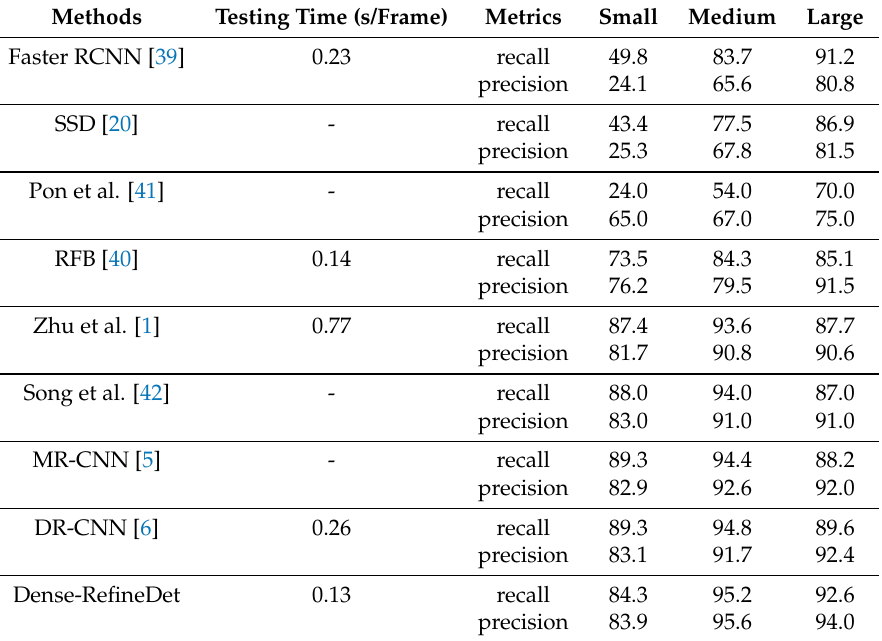
Table 1. Comparisons of detection results on the Tsinghua-Tencent 100K